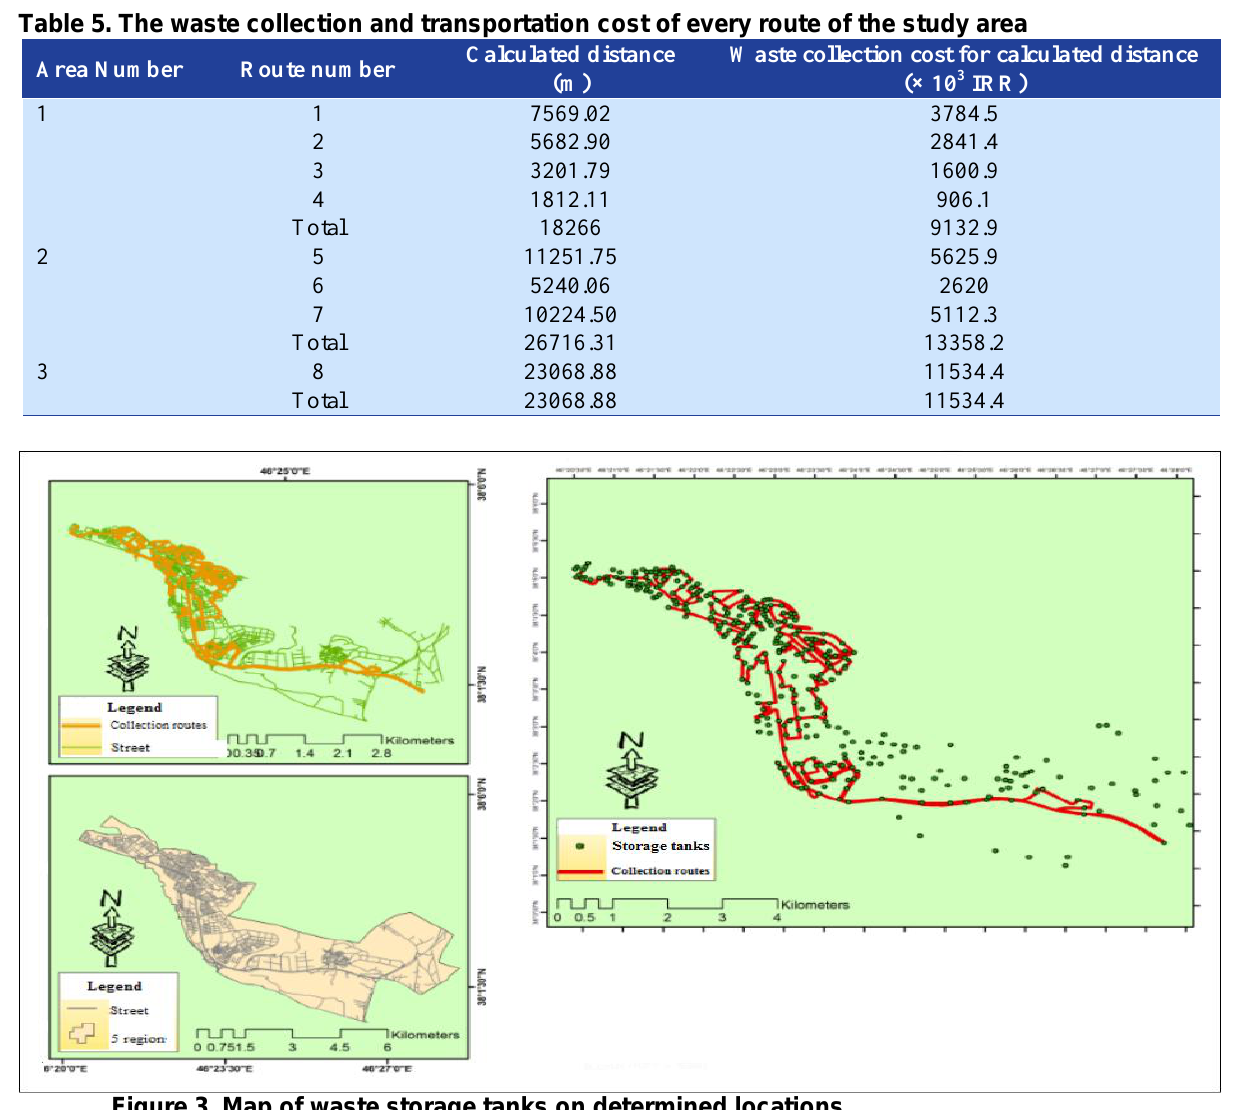
Figure 3. Map of waste storage tanks on determined